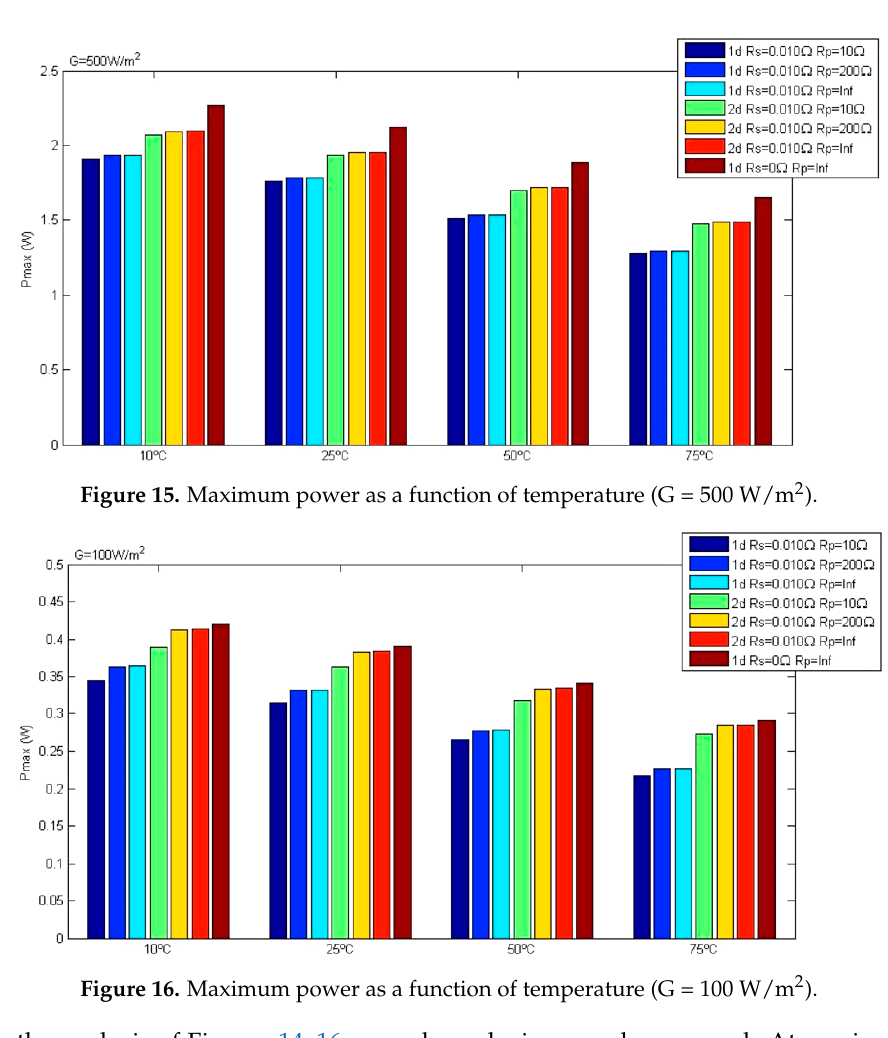
Figure 16. Maximum power as a function of temperature (G = 100 W/m 2 ).